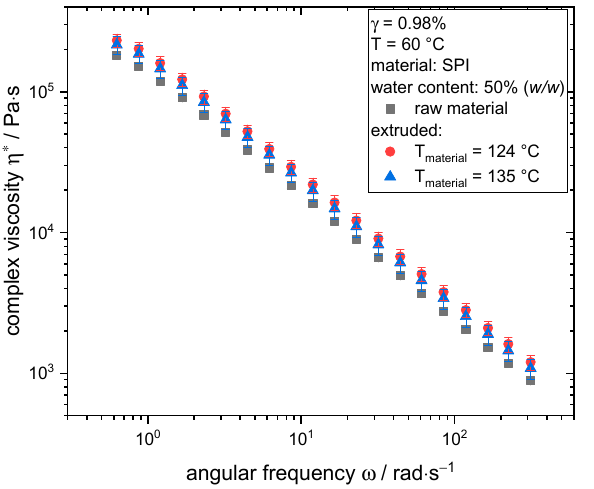
Figure 5. Frequency sweeps ( γ = 0.98%) of raw material and extruded samples at T = 60 °C and water content of 50% ( w/w ).